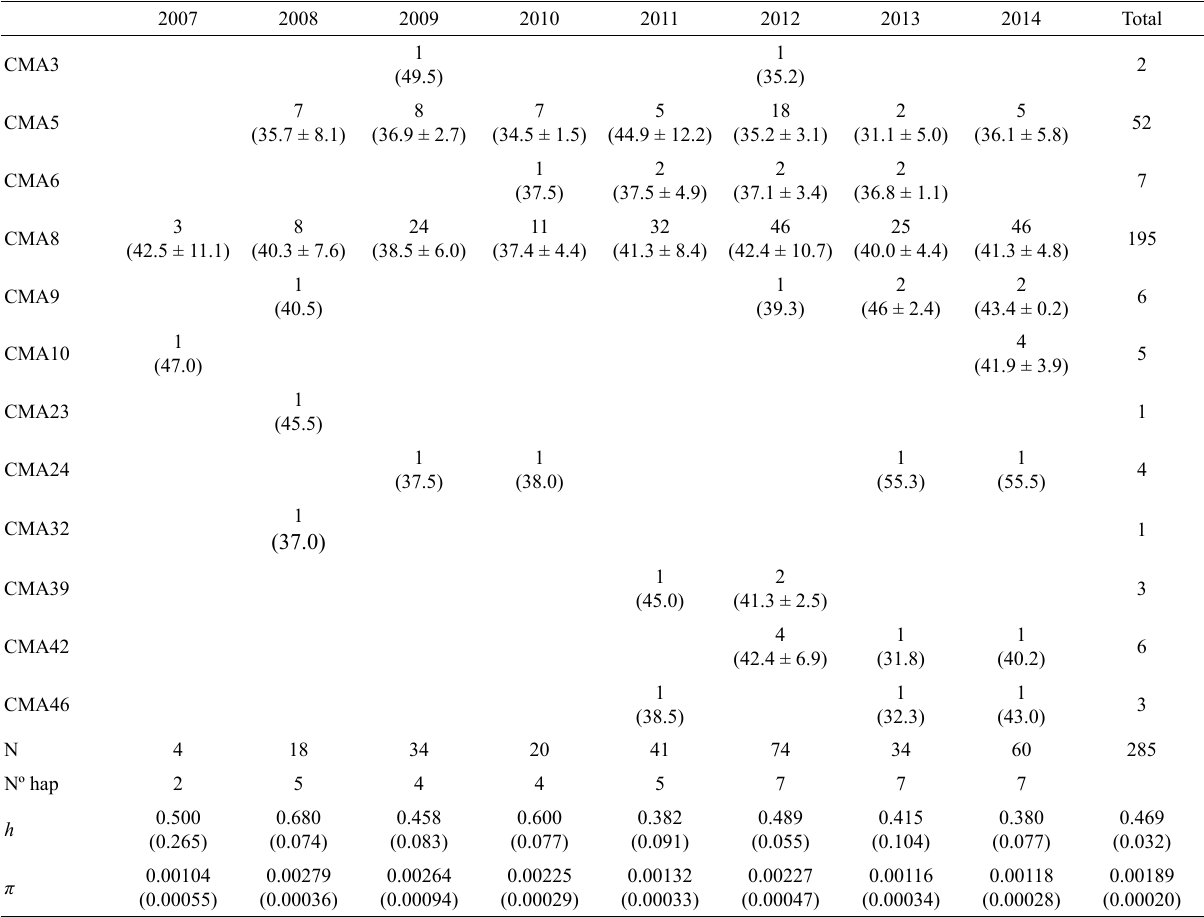
Table 1 ‒ Number of juveniles green turtle from each haplotype in each sampling year (N), with the CCLs (cm) or mean CCLs (cm) (±SD); number of haplotypes per year (Nº hap); haplotype diversity ( h ) and nucleotide diversity